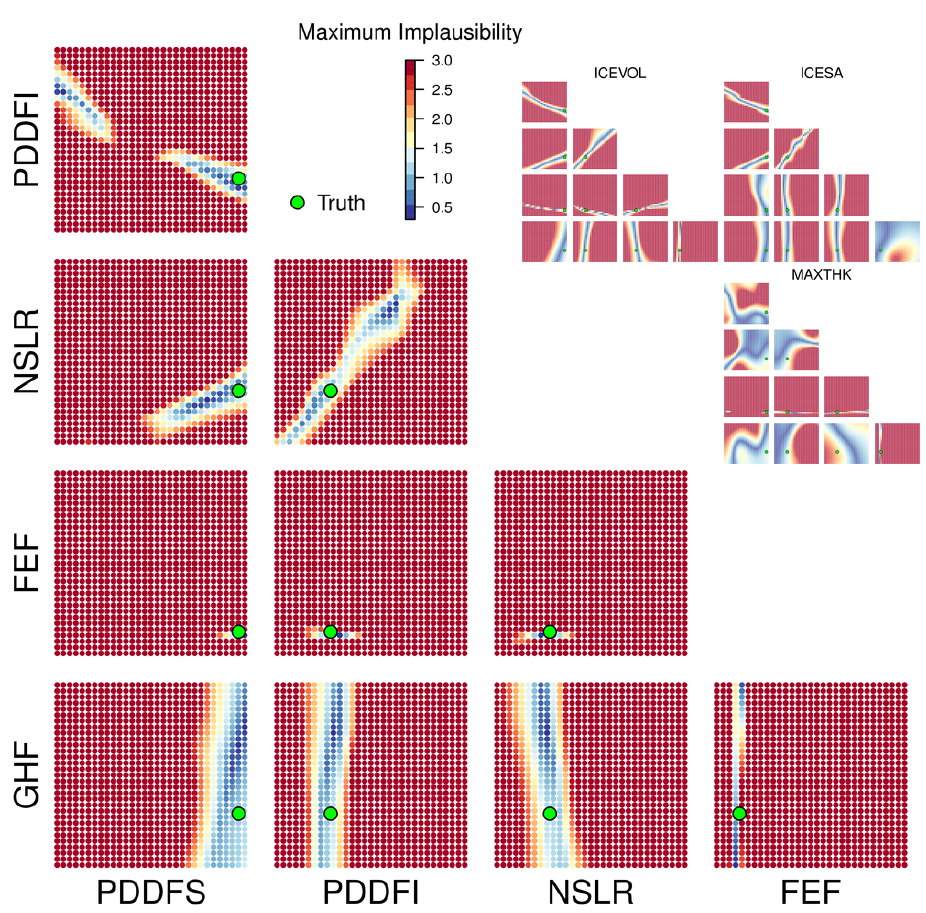
Fig. 6. A “two-at-a-time” sensitivity analysis of the (arbitrarily chosen) first ensemble member. Each subplot (main figure) shows the emulated implausibility measure I , when the named inputs are varied across a regular grid, and the remaining three inputs are held at their true values. Contributions to the final “maximum implausibility” measure from each observation type are shown in the inset (top right), and the true values of the ensemble member are plotted as a green point.